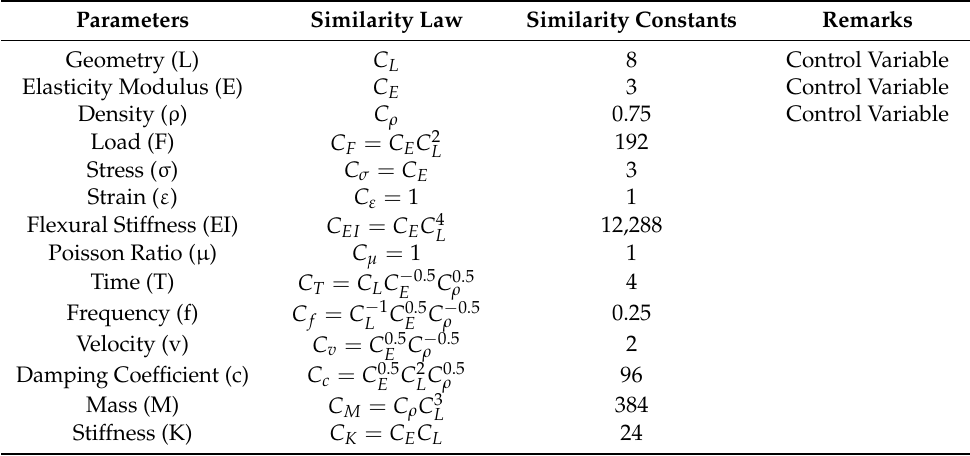
Table 1 . The similarity ratios of the test model.